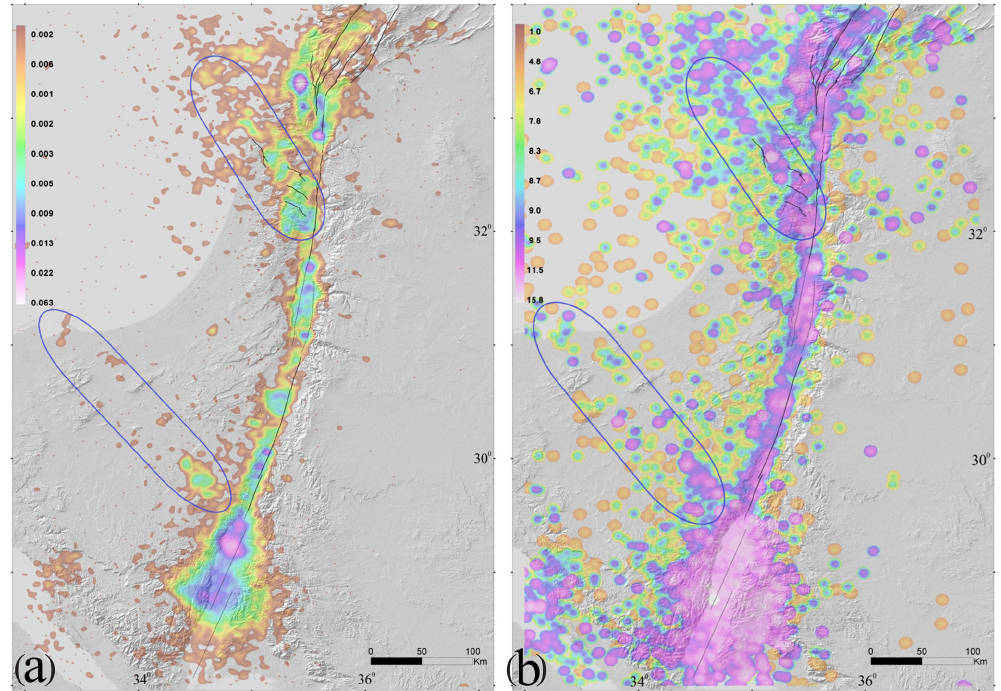
Figure A4. Marked ∼ NW trending seismicity lineaments: CTF (north) and the EBL (south), on the distribution maps of the earthquake density (a) and seismic moment density (b) , as in Figs. 3 and